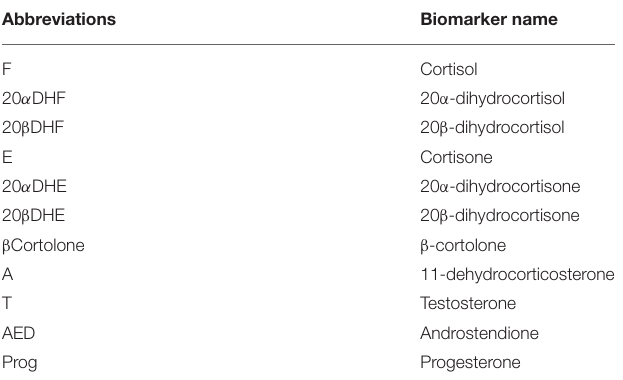
TABLE 3 | List of biomarkers of the hypothalamic-pituitary-adrenal axis (HPA) and gonadal axis obtained by LC-MS/MS analysis of hair samples (abbreviation and full